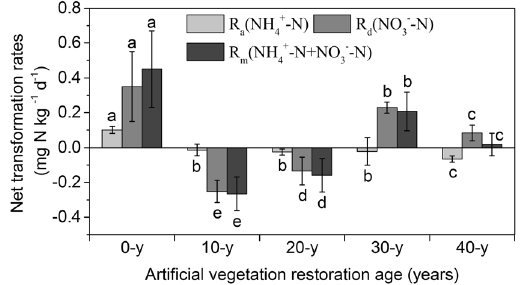
Figure 1. Net transformation rates of R a (NH 4 + -N), R d (NO 3 − -N), and total mineralization (R m ) during artificial vegetation restoration. Values are means ± standard error (n = 3). Different letters indicate significant differences ( P < 0.05) among soils for the individual variables based on a one-way ANOVA followed by an LSD test.